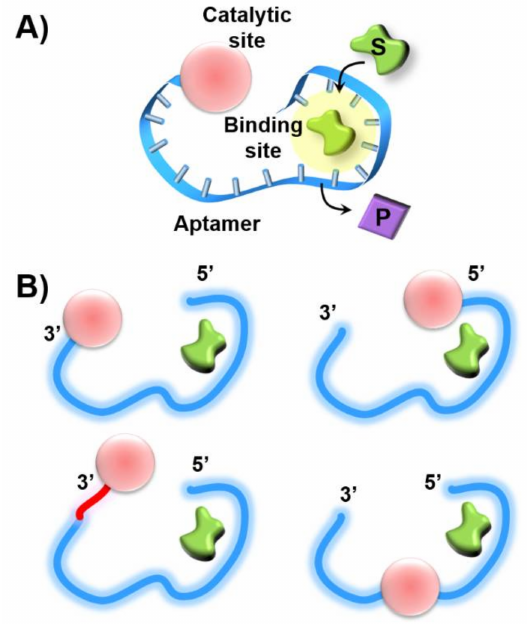
Figure 12. ( A ) Schematic structure of a nucleoapzyme consisting of a catalyst and aptamer conjugate. ( B ) Schematic library of nucleoapzymes consisting of a catalyst linked directly, or through a space bridge, to the 3 (cid:48) - or 5 (cid:48) -ends of the aptamer scaffold, or where the catalyst separates the “split” aptamer